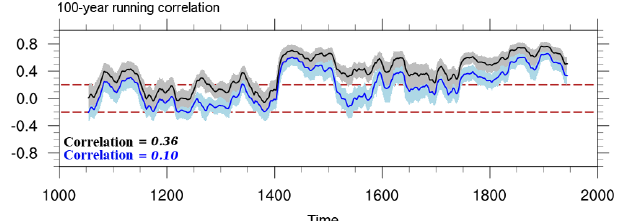
Figure 7. 100-year running correlation between BSL and ESL (black) and between BSL and median-reduced ESL (blue) with shading marking the uncertainty of the correlation using bootstrap- ping. Time series have been smoothed with an 11-year moving win- dow prior to calculating the running correlations. Dashed red lines mark significant correlation on the 95th percentile confidence level. The long-term correlation is given in the bottom left